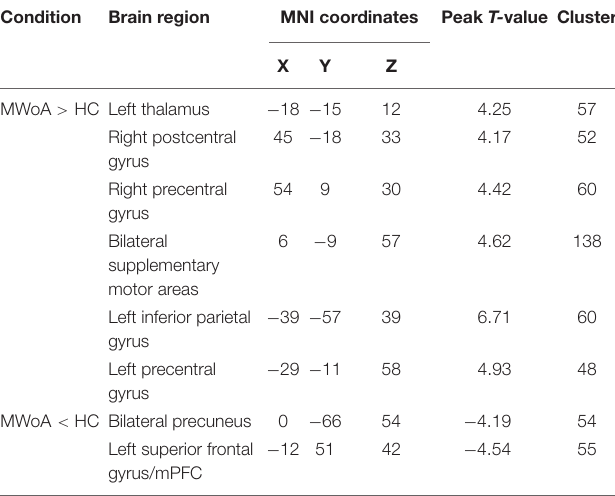
TABLE 2 | Brain regions showing differences in fALFF for migraineurs compared to HCs.